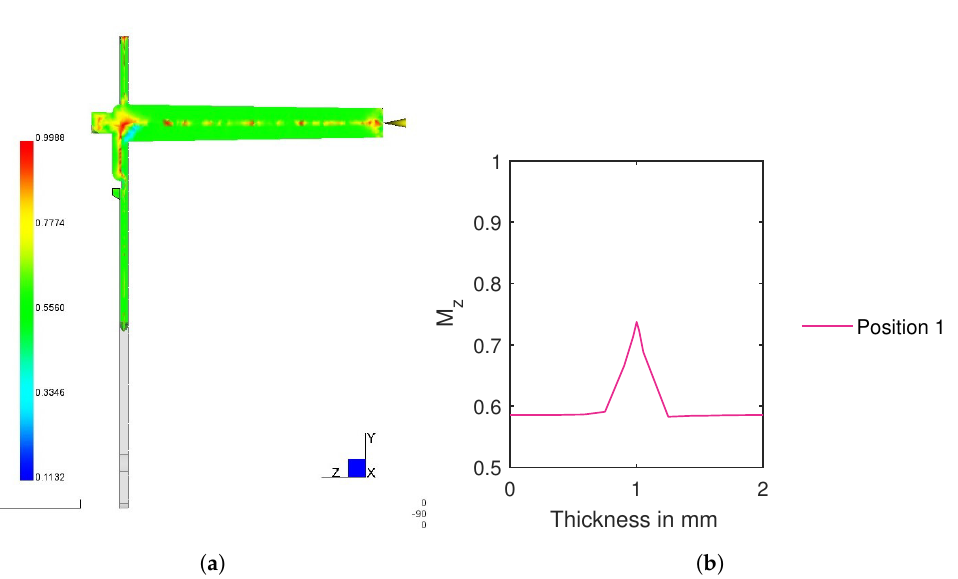
Figure 14. Evaluation of the Manas-Zloczower number calculation. ( a ) Cross-section of plate after 0.41 s of filling time. ( b ) Graph of M z against the thickness of the plate at Position 1 once the node is fully filled for the first